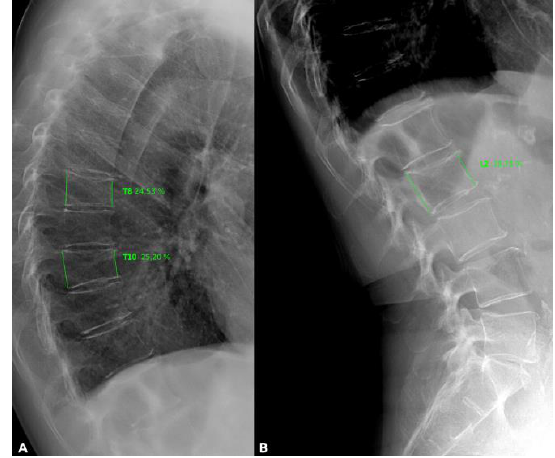
Figure 1. ( A ). Lateral thoracic radiograph showing (green lines) vertebral fractures in T-8 and